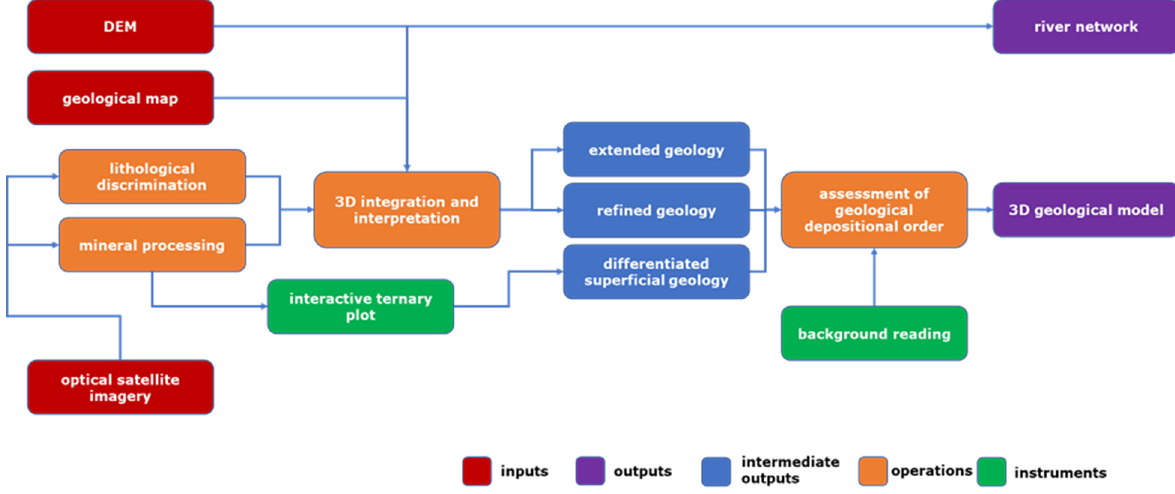
Figure 7. Geological processing workflow .